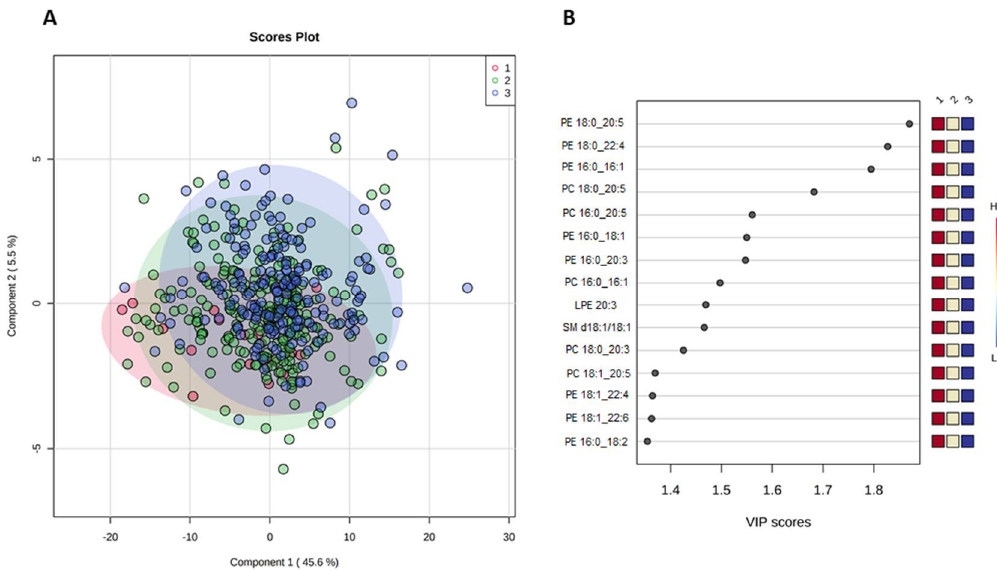
Figure 5. Outputs of the PLS-DA of lipid species on the cardiovascular health status. ( A ) PLS-DA scoreplot and ( B ) im- portance of variables ranked by Variable Importance in Projection (VIP) score for the comparison between categories of cardiovascular health. 1 = Poor; 2 = intermediate; 3 = ideal.